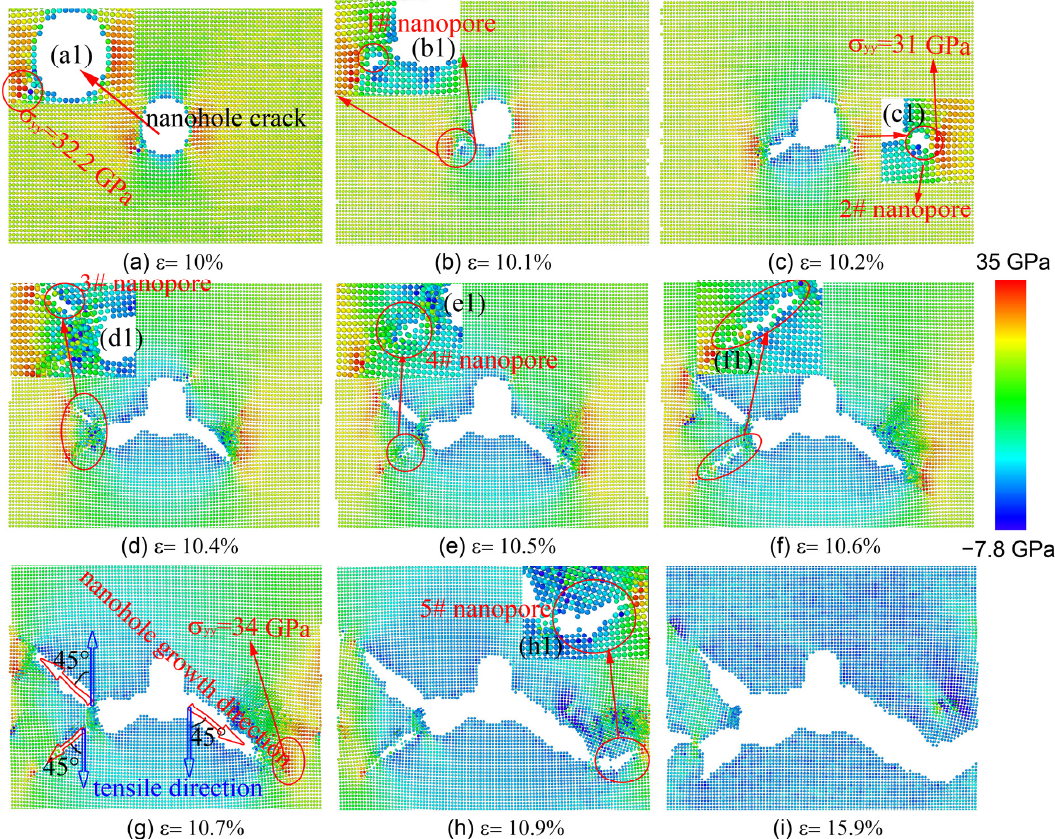
Figure 4. The contour plots of the atomic tensile stress field and nanohole growth states at different tensile strains (MEAM potential).